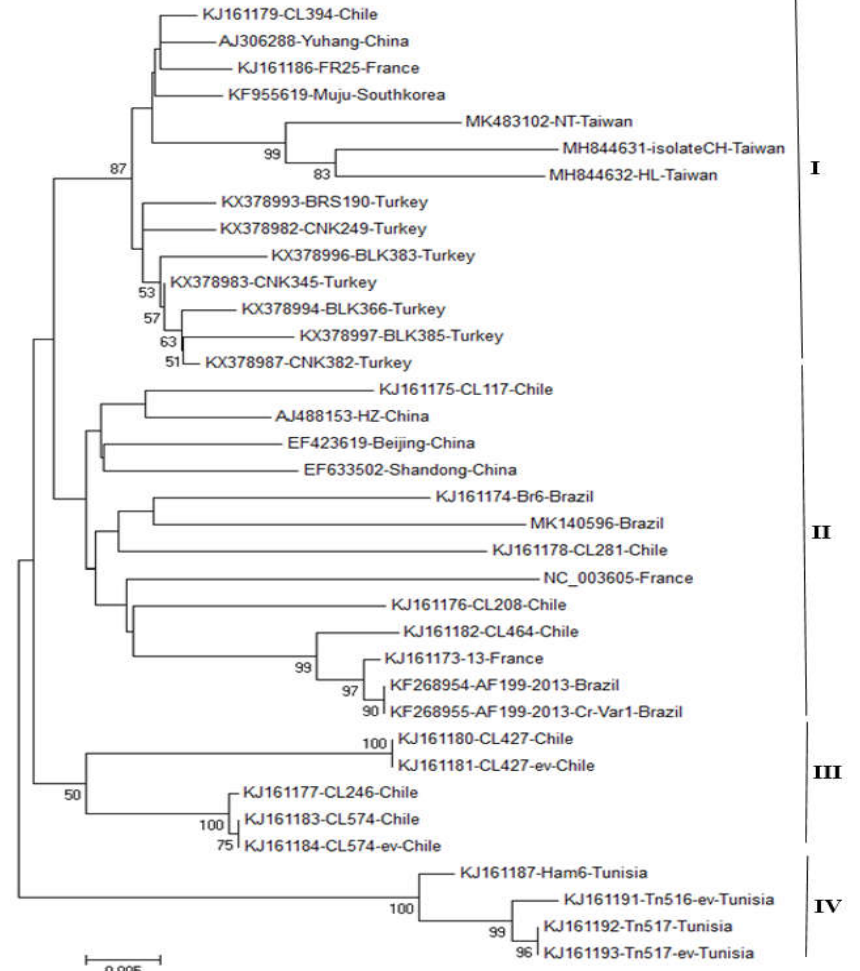
Fig. 1. Phylogenetic relationship of global Lettuce mosaic virus isolates constructed based on the complete CP gene sequences using Neighbor-Joining (NJ) method and Tajima model implemented in MEGA v.7.0.21. Branch support was computed using the bootstrap method based on 1000 replicates. Bootstrap values over 50 % are given at the